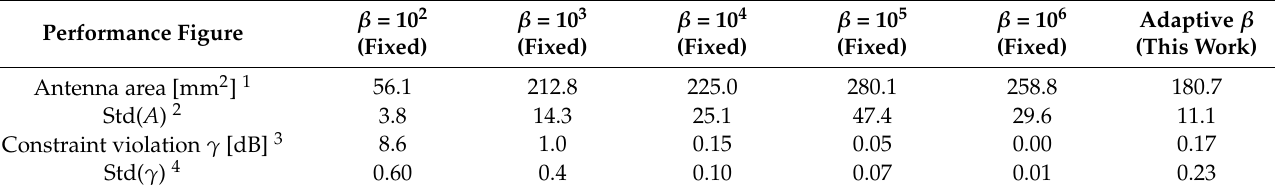
l 2 Figure 8. Geometry of Antenna III: the light gray shade is the ground plane on the backside of the structure.